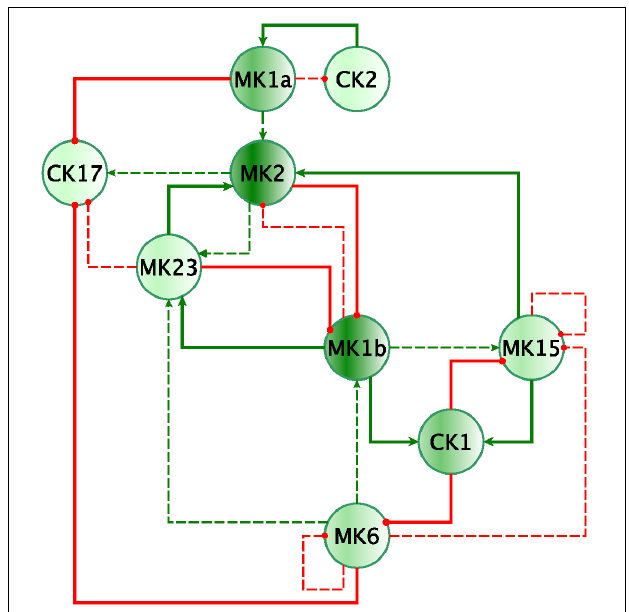
FIGURE 3 | Mechanistically informed HC regulatory motif. Regulatory interactions extracted from documented prior knowledge (STRING and Fritsch et al., 2013) that are uniquely represented in the experimental data in HC during recovery from maximum exercise. Solid lines represent interactions uniquely expressed in HC while dashed lines show control actions shared with GWI. Green arrows indicate a stimulatory action whereas a red “T” terminators indicate suppressive